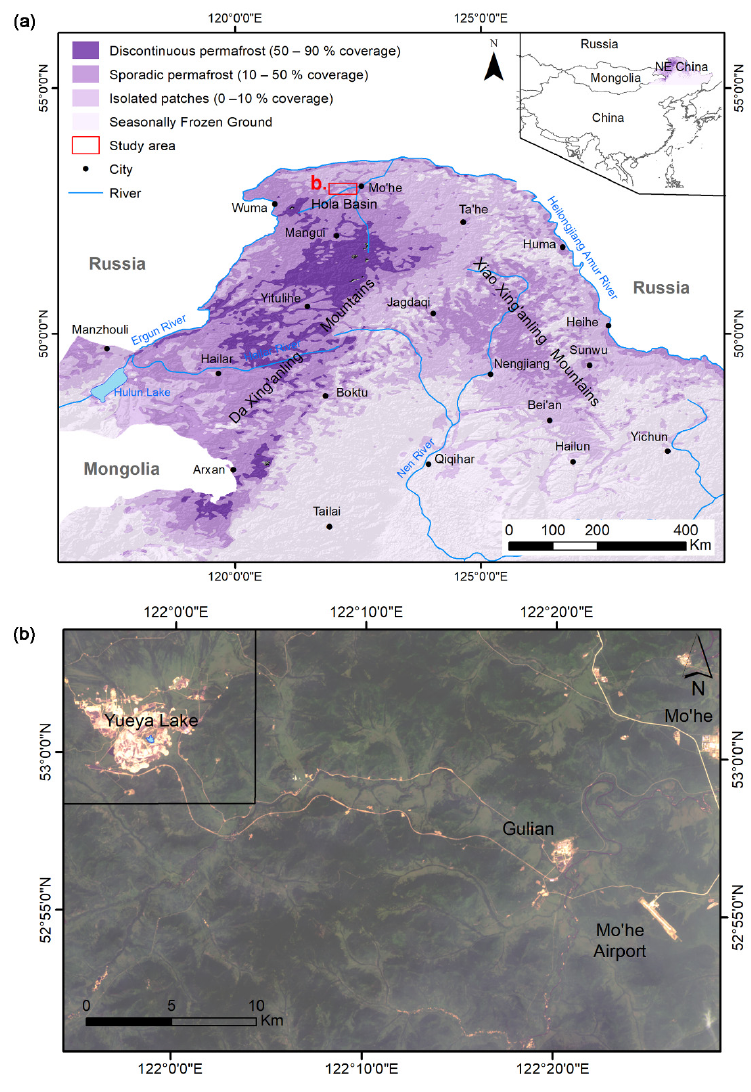
Figure 1. ( a ) Study area location in Northeast China. Permafrost distribution after Obu et al. [31]. ( b ) Landsat 8 OLI image (band combination red-green-blue) from 1 August 2019 for the Hola Ba- sin.